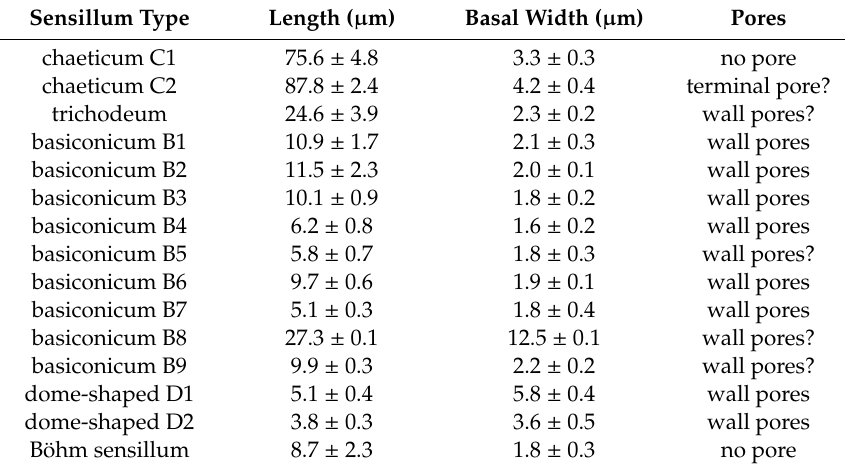
Table 2. Morphological characteristics of di ff erent sensillum types and subtypes in Agriotes species. ?, pores hypothesized but not clearly visible in the studied material.